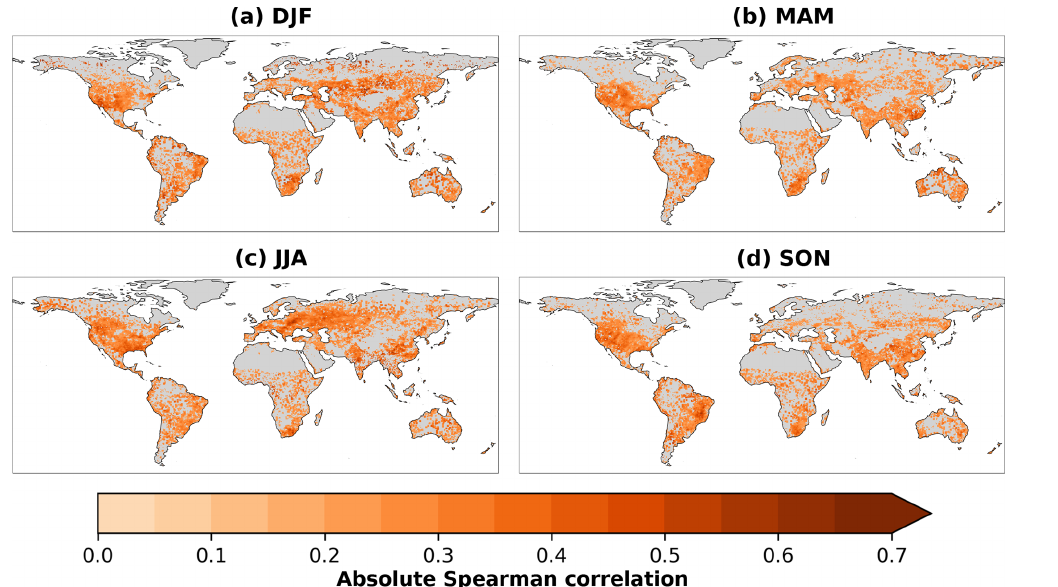
Figure 4. Strongest absolute Spearman correlation coefficient between the Earth system variables in Table 1 and the temperature forecast error. The values correspond to the respective most relevant individual variables shown in Fig. A3. Only correlations that are significant after correction for multiple testing are